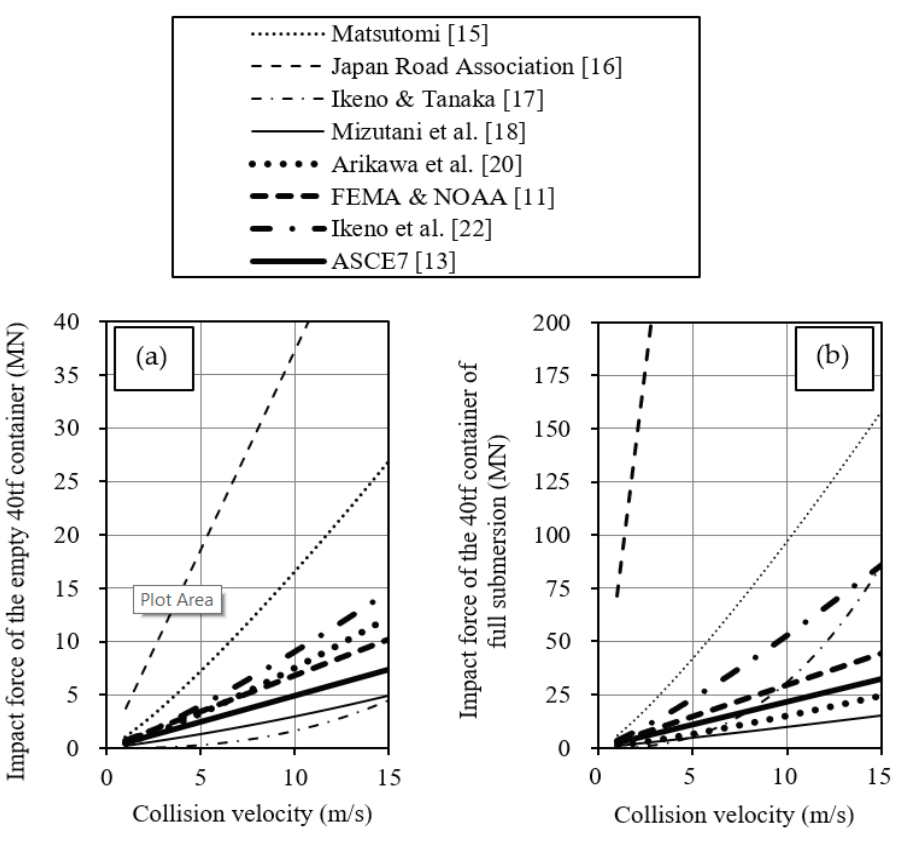
Figure 10. Impact force of the 12.2 m container: ( a ) the empty container, and ( b ) the fully-loaded container.